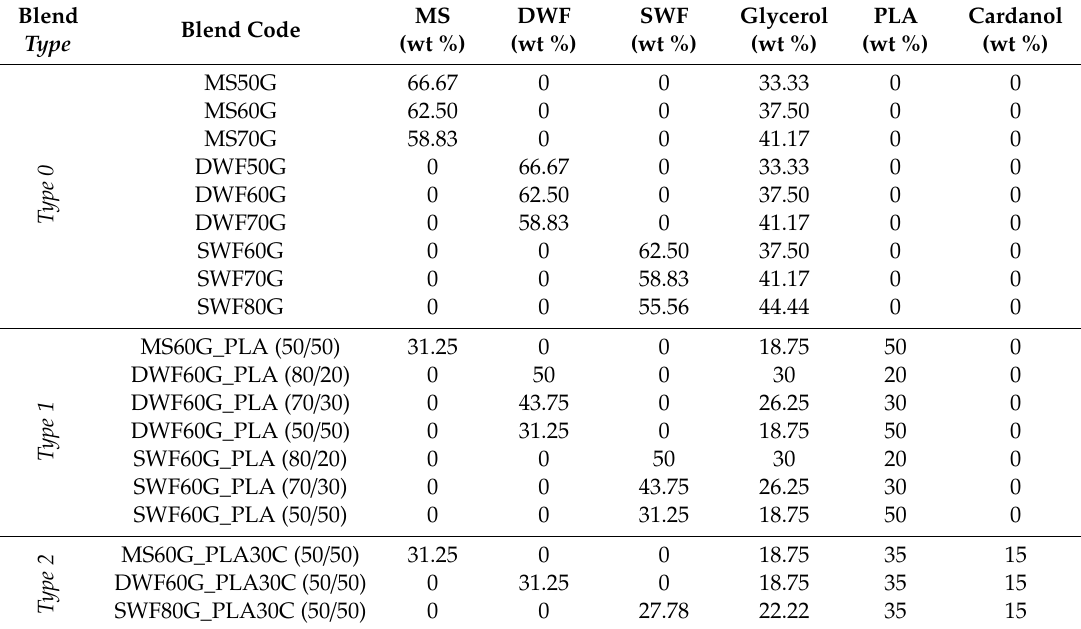
Table 1. Composition of the blends: maize starch (MS), glycerol (G), durum waste flour (DWF), soft waste flour (SWF), polylactic acid (PLA) and cardanol (C) contents. Blend